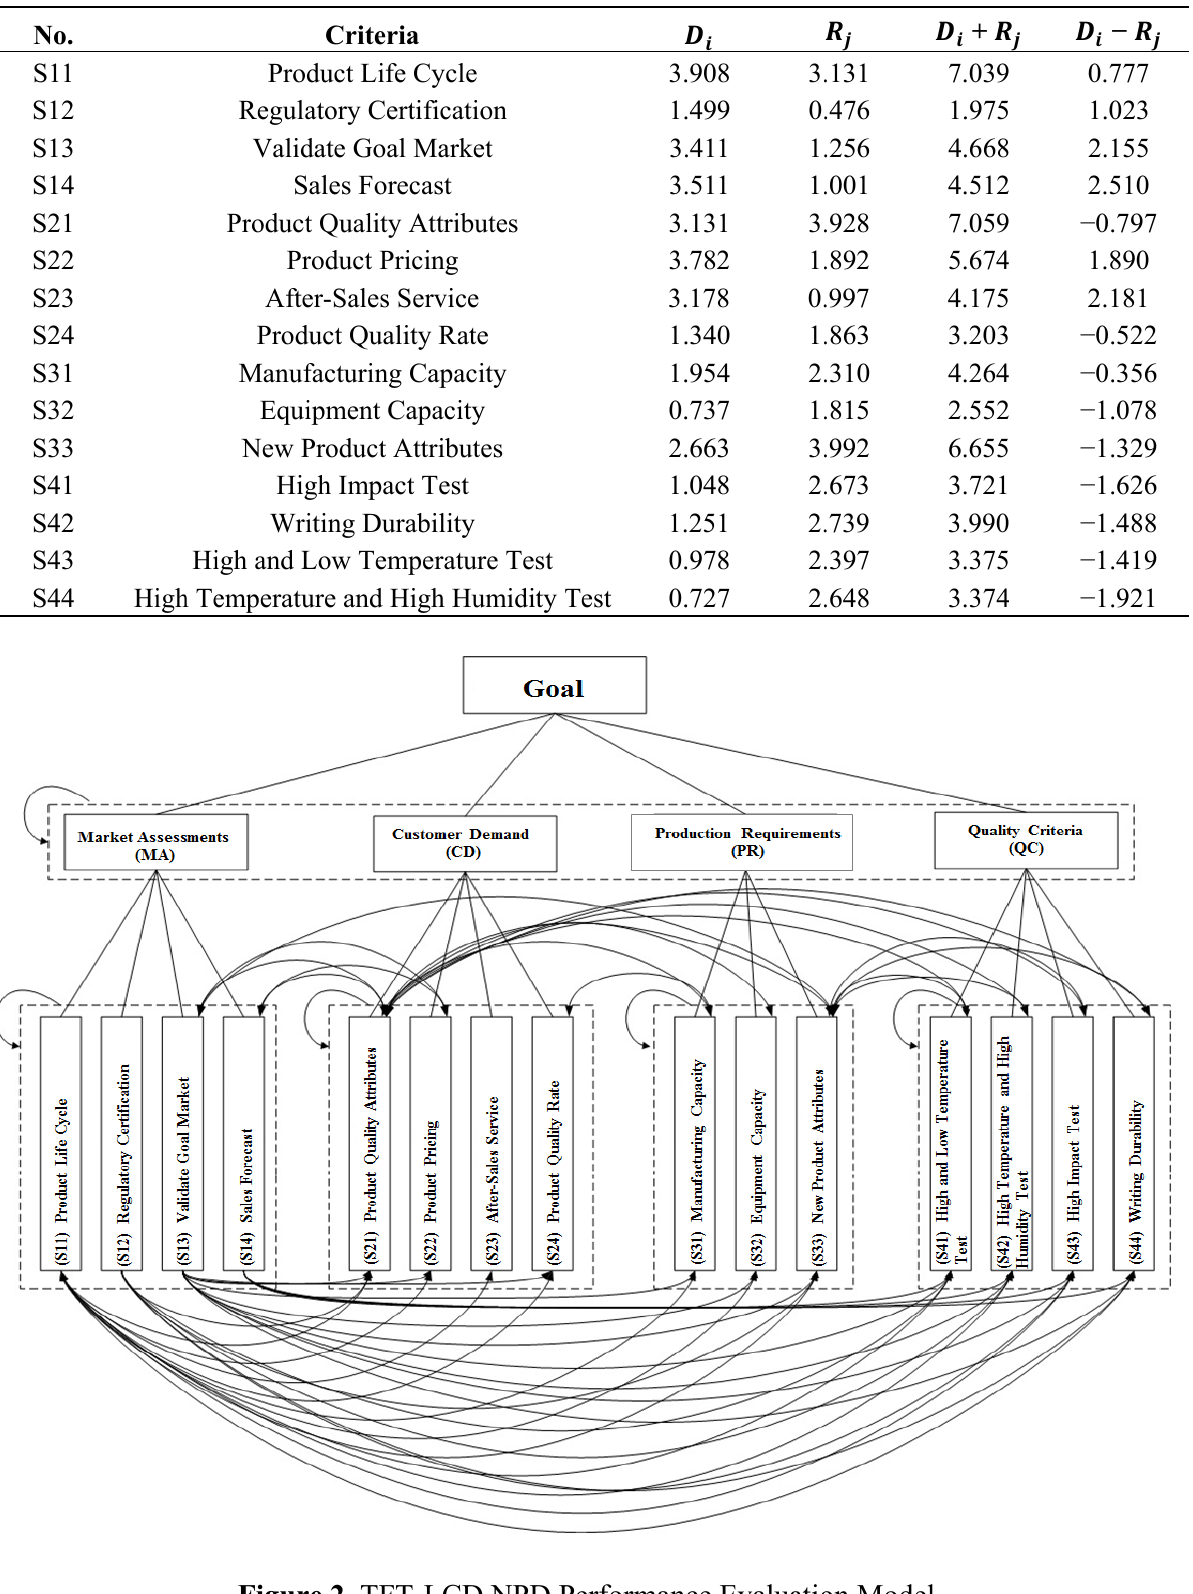
Table 7. Relevance and Impact between Criteria after Integration.